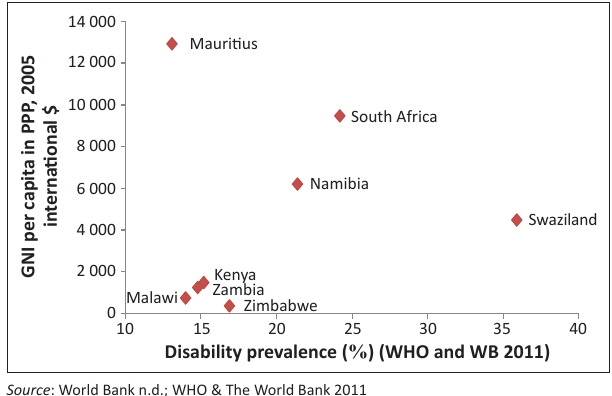
FIGURE 1: Disability and Human Development Index in Eastern and Southern Africa.